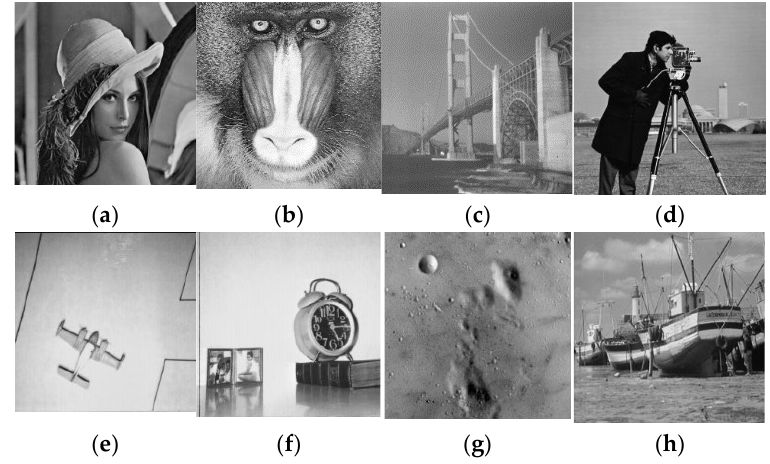
Figure 4. Original input images: ( a ) Lena; ( b ) baboon; ( c ) bridge; ( d ) cameraman; ( e ) airplane; ( f ) clock; ( g ) moon; ( h ) ship.